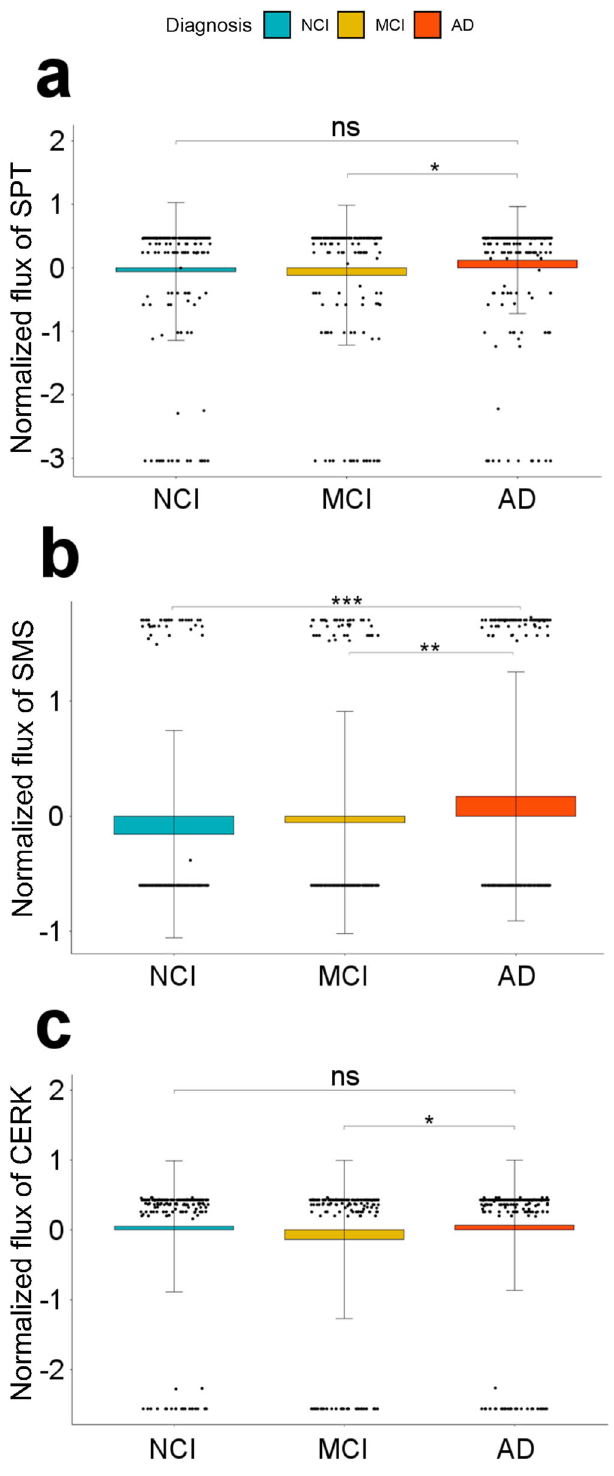
Fig. 2 In silico fl ux analysis for metabolic reactions in the sphingolipid pathway. Box plot of normalized reaction fl uxes for a serine palmitoyl transferase (SPT), b sphingomyelin synthase (SMS), and c ceramide kinase (CERK) reactions. The orange, mustard yellow, and blue bars correspond to Alzheimer ’ s Disease (AD), mild cognitive impairment (MCI), and no cognitive impairment (NCI). ∗ p < 0.05, ∗∗ p < 0.01, ∗∗∗ p < 0.001, and ns is non-signi fi